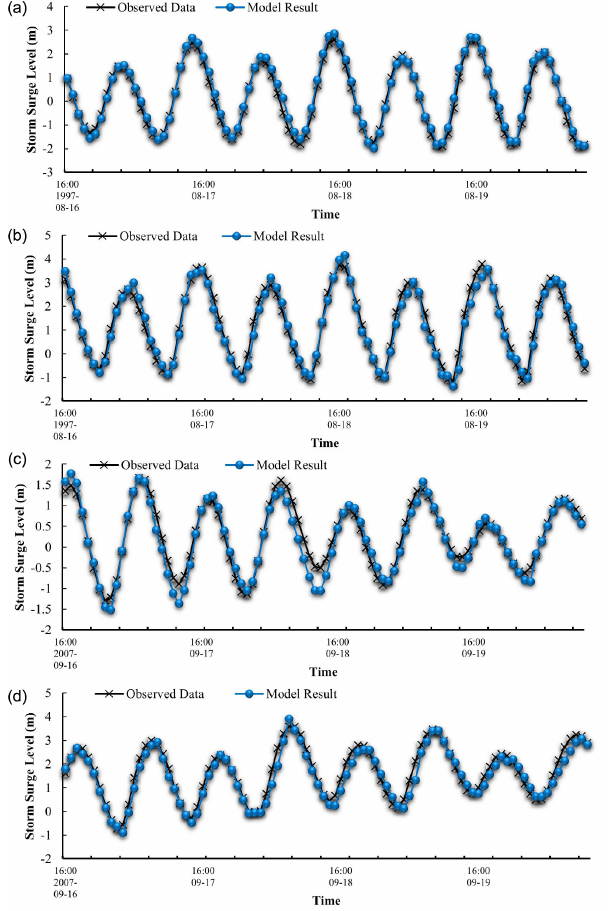
Figure 7. Comparison of the observation data (black) and simulated results (blue) of storm surge levels (a, b) during Typhoon Winnie and (c, d) during Typhoon Wipha at Daji and Tanxu